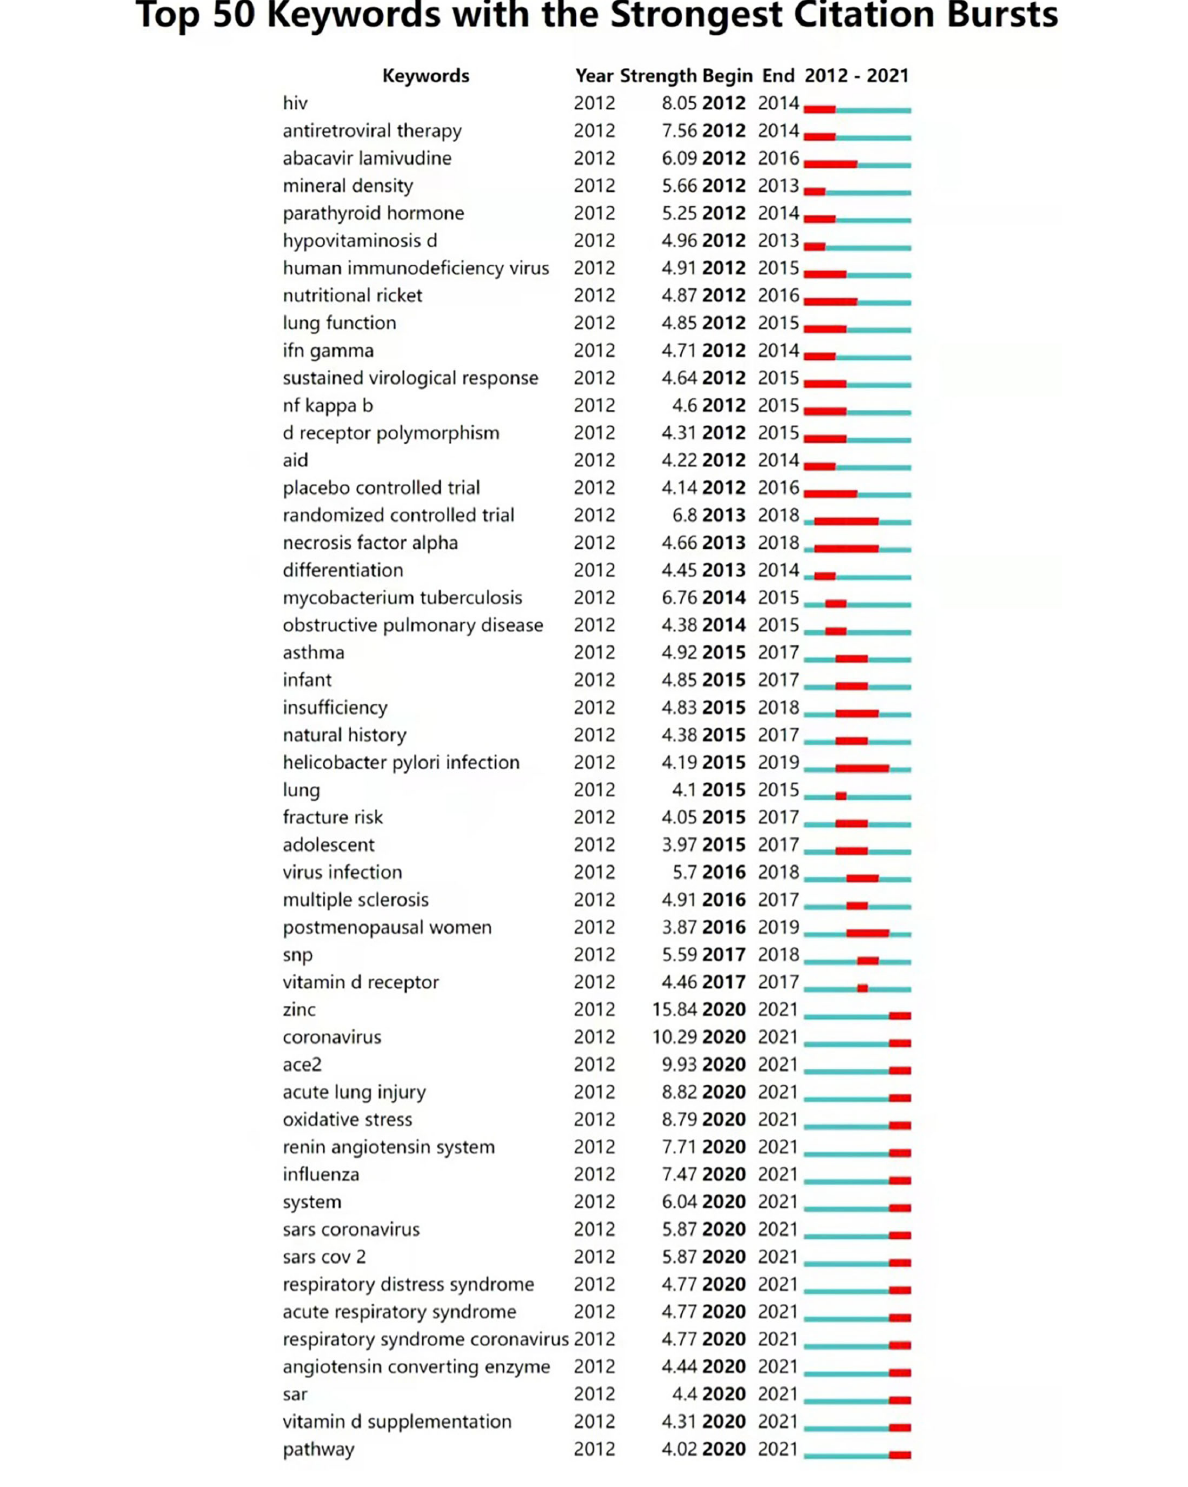
FIGURE6 Top 50 keywords with the strongest citation burst (2012–2021). The blue line indicates the time-lapse, and the red line indicates the duration of the quote burst, which shows the progression of cutting-edge hot